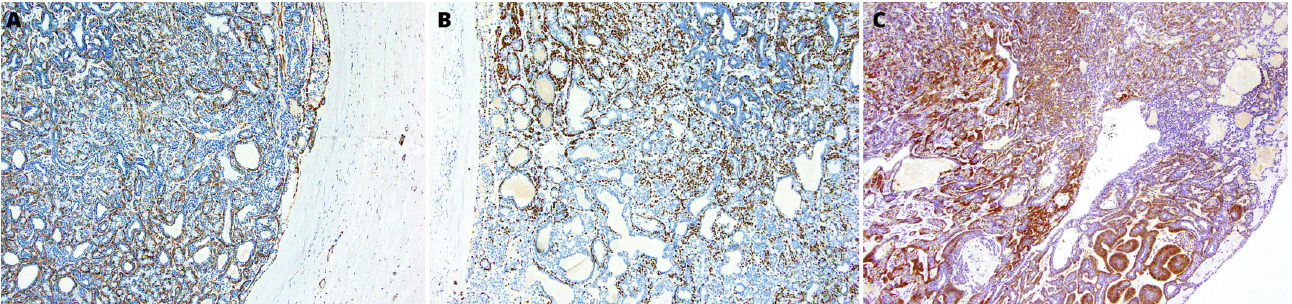
Figure 3. ( A ) Positive immunohistochemical staining for smooth muscle actin (SMA), ( B ) p40 and ( C ) DOG1. Obj. magnification 200×.